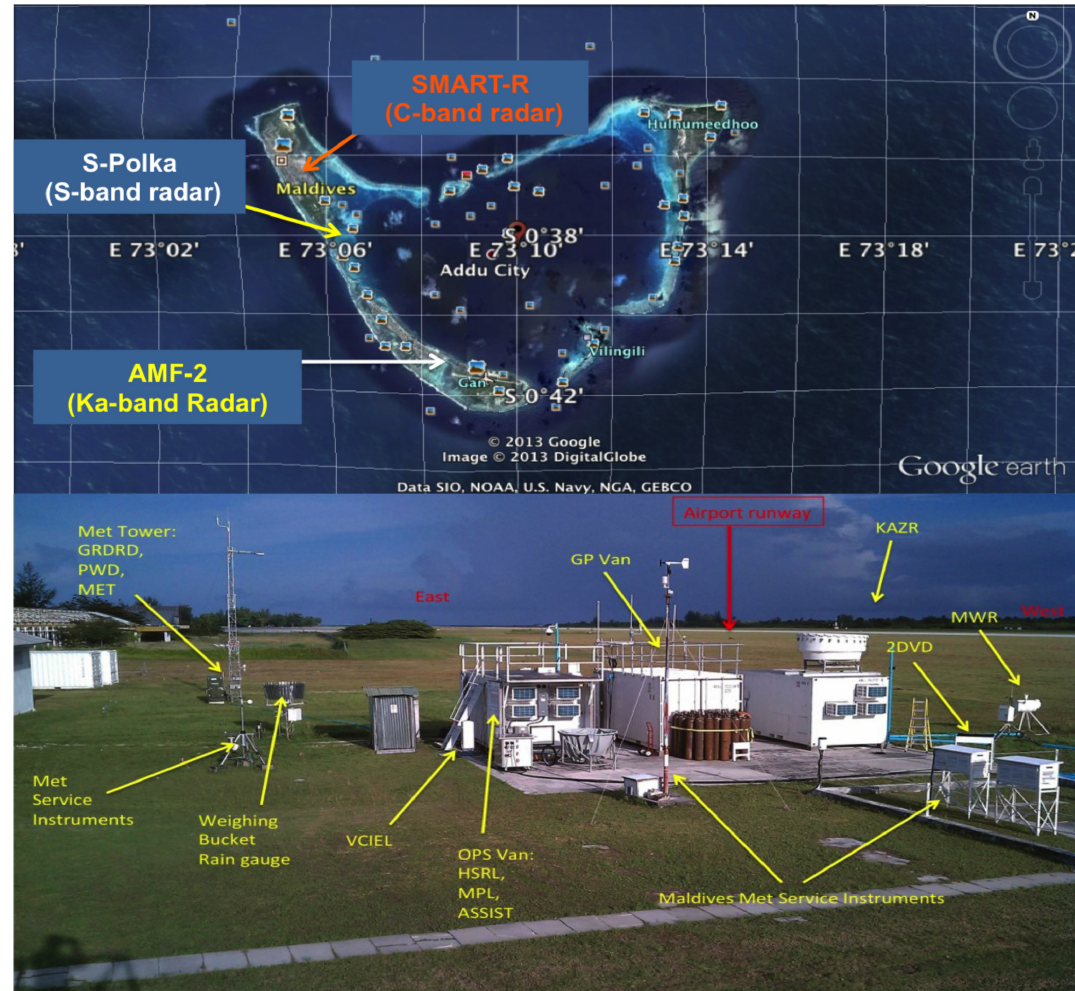
Figure 1. Top: aerial view of the radar triad on Addu Atoll (top) and AMF-2 instrument setup at Gan Island (bottom) during the DY- NAMO/AMIE field campaign. Table 1. Specifications of radars used in this